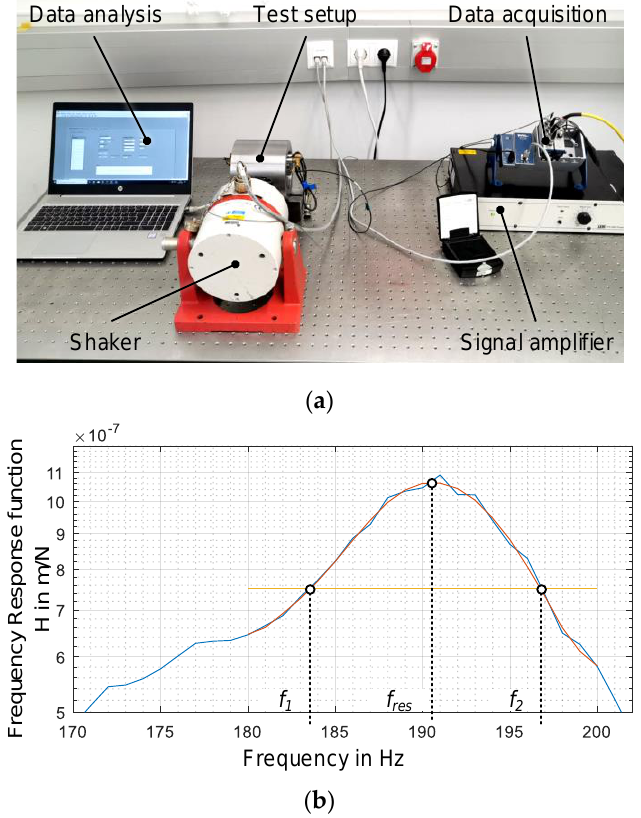
Figure 7. ( a ) test setup for dynamic testing of resilient bearing suspensions; ( b ) frequency response function to determine stiffness and damping behavior.